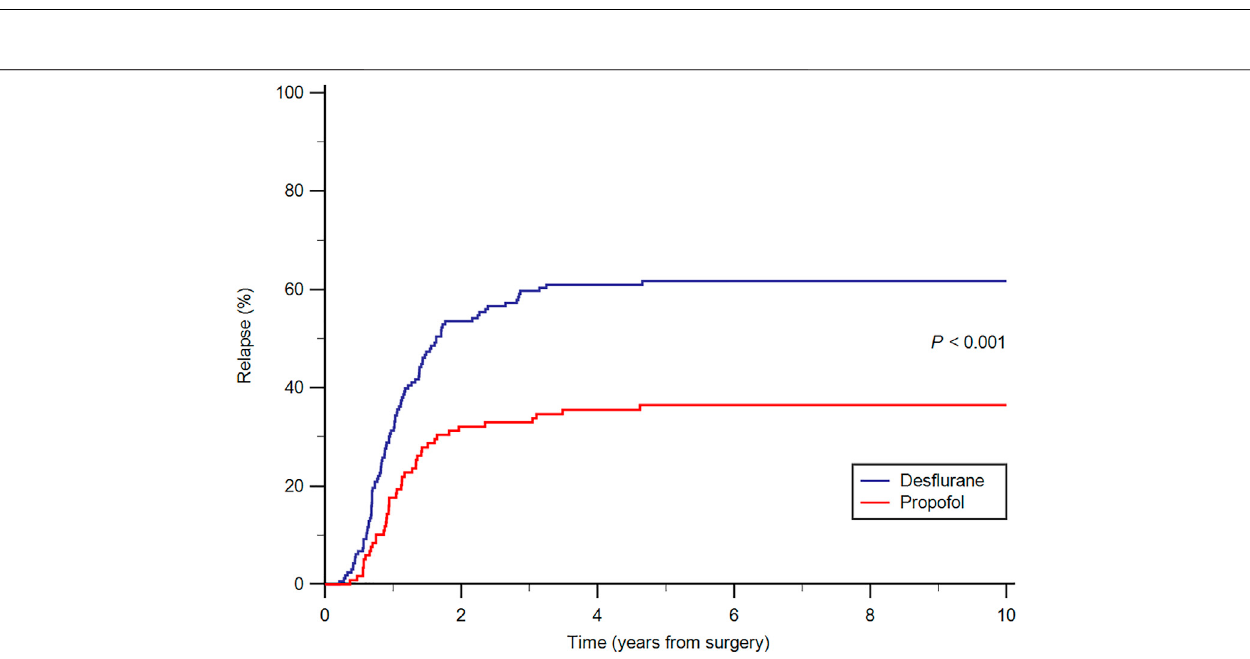
FIGURE 3 | Cumulative relapse curves from the date of surgery by anesthesia type.